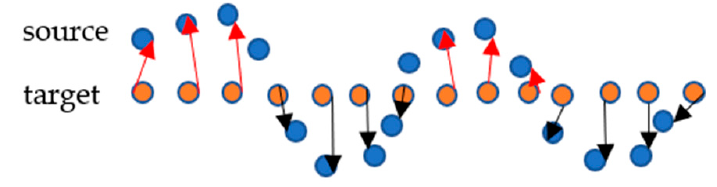
Figure 4. Direction of change distance calculation.